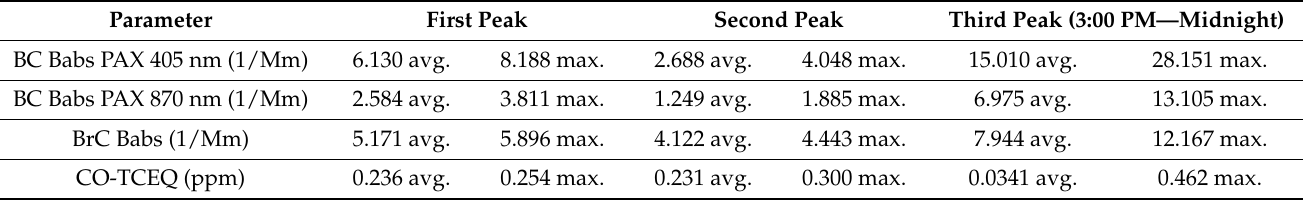
Figure 2. PAX 870 nm and PAX 405 nm Babs due to BC ( a ) and BrC ( b ). Each hour ( x -axis) represents daily averages calculated over January 2022. The error bars represent the standard error for each point average. The graphs have a smoothing filter applied (binomial smoothing by Wave Metrics Igor Pro 8 platform). The vertical line at 15 h (3:00 PM) divides baseline Babs output from the eventful behaviors driven by an increase in biomass burning during late evenings. The boxplot ( c ) represents the spread of the data at 10 min average. Table 1. The average and maximum values of the BC and BrC Babs (Babs, Mm − 1 ) for \ the three prominent peaks in Figures 2a,b and